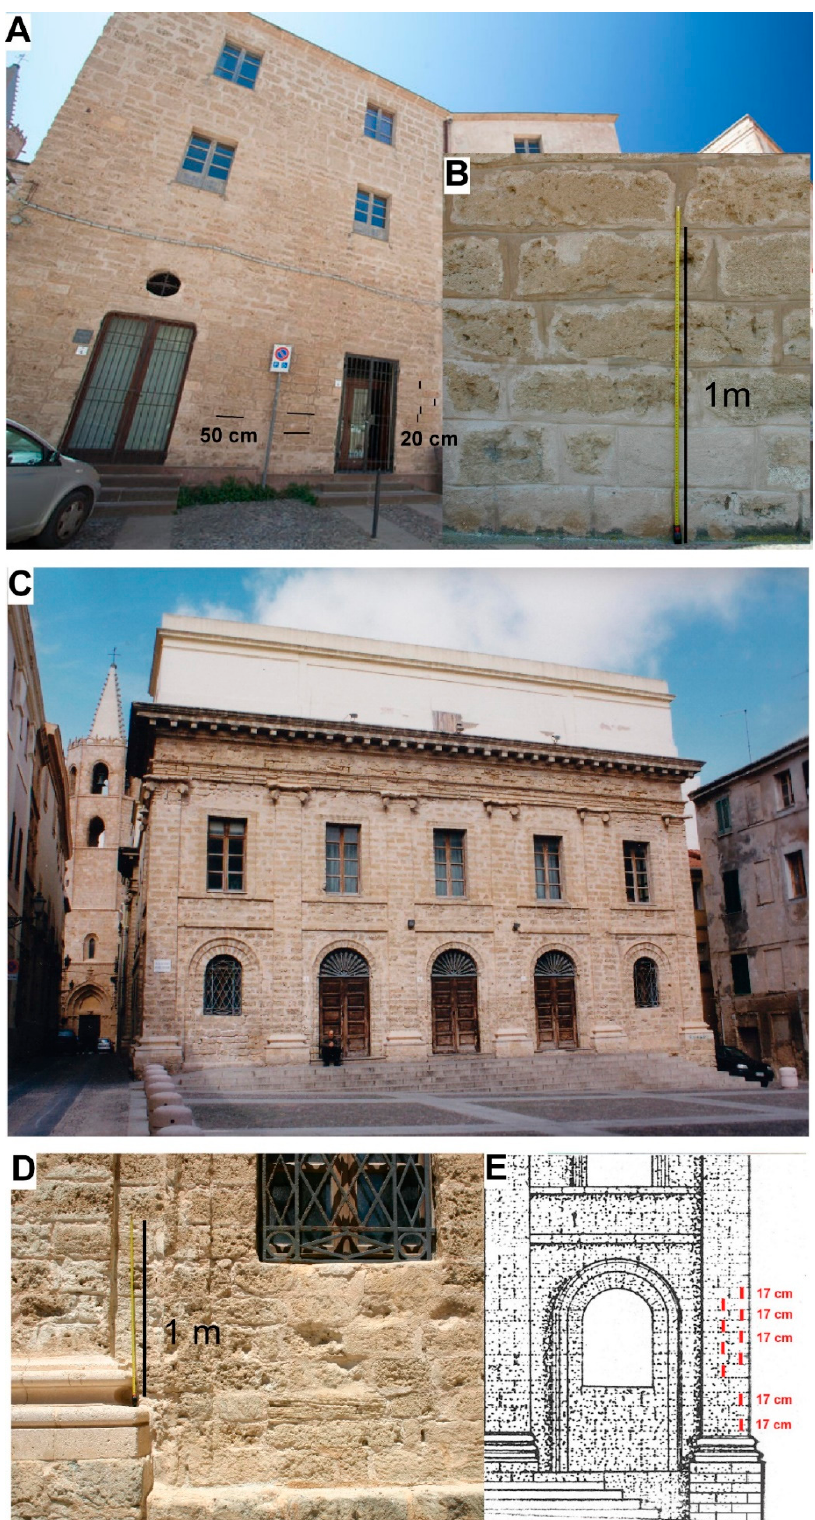
Figure 14. ( A ) Alghero buildings of the 16th to 18th Centuries—the Palazzo del Pou Salit. ( B ) Detail of blocks used for the building. ( C ) Alghero buildings of the 18th to 19th Centuries—the City Theatre. ( D ) Detail of the dimension stones used for the Theatre. ( E ) Sketch of the façade of the Theatre enhancing di-dimension of used blocks.